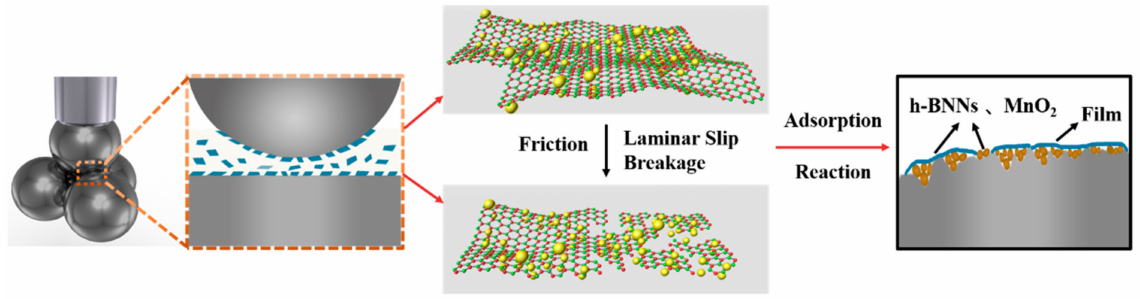
Figure 13. Schematic diagram of lubrication model of MnO 2 @h-BNNs additive in PAO6